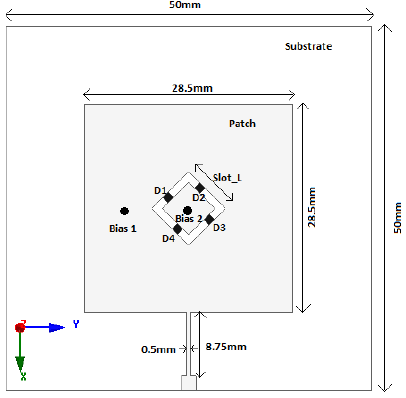
Figure 1: Geometry of proposed antenna Four ultra-miniature p-i-n diodes (NXP BAP50-03, 50mA, 50V,) are placed in the diagonal slot for polarization reconfiguration. When ON-state the diode has a series resistance and inductance of 5 Ω and 1.8 nH and when OFF- state the diode has a shunt capacitance is 0.35 pF with the